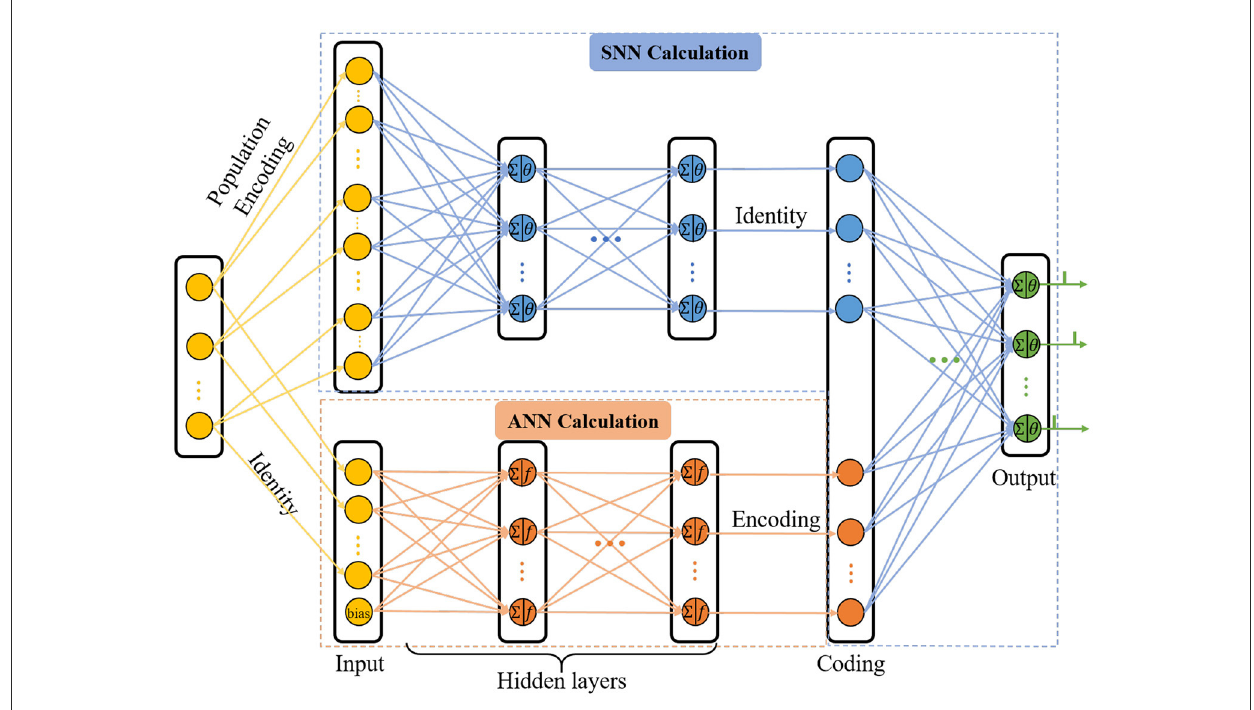
FIGURE3 The topology structure of